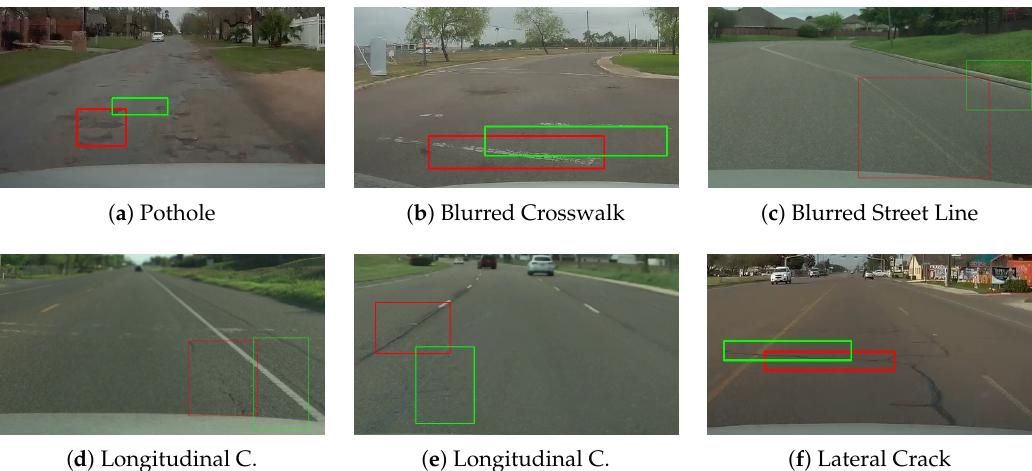
Figure 6. Examples of false positive predicted bounding boxes; notice that, in order to be considered true positive, the IOU has to be equal to or greater than 50%.